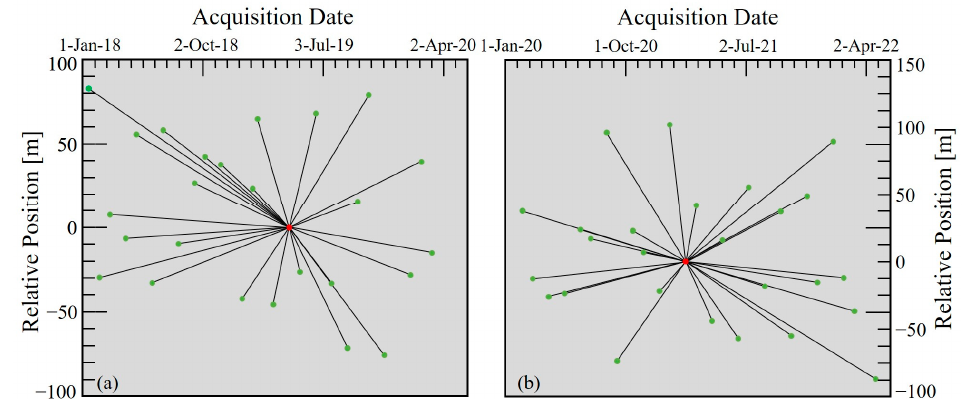
Figure 3. ( a ) Space–time baseline plot from January 2018 to March 2020. ( b ) Space–time baseline plot from February 2020 to April 2022.